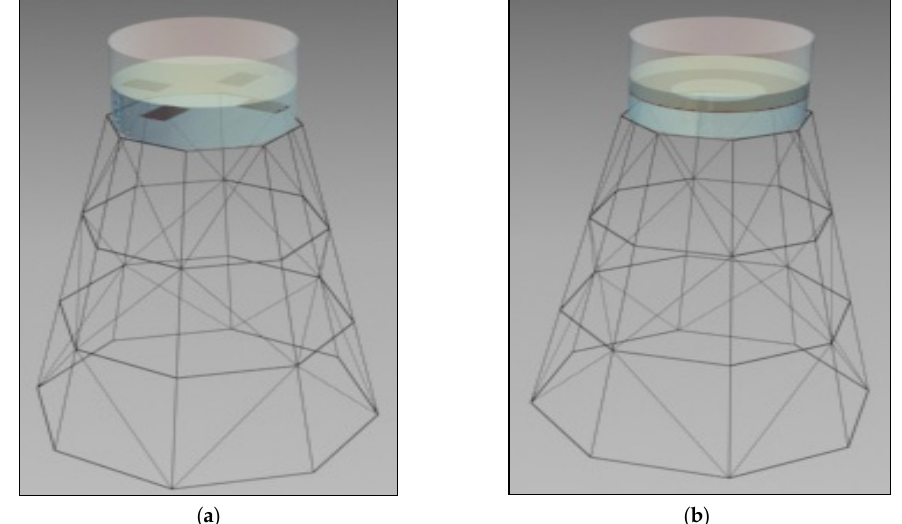
Figure 1. Schematic view of an elevated storage tank half-filled with fluid equipped with a baffle. ( a ) Horizontal baffle; ( b ) annular baffle.